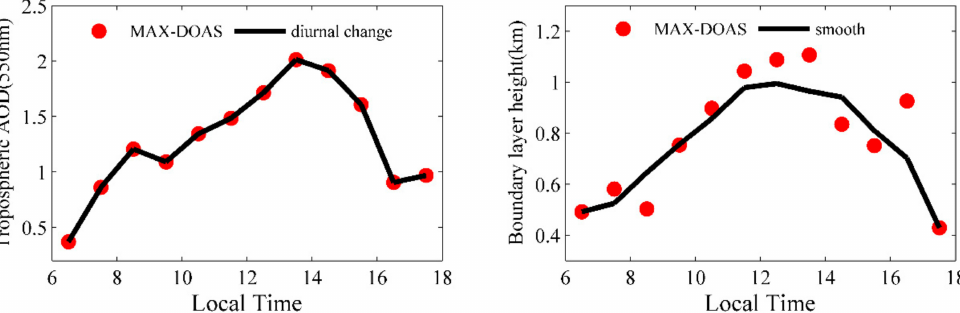
Figure 8. Diurnal variation of AOD and boundary layer height in Shanghai from 28 July to 5 August 2015 (6:00~18:00 LT). The red dots indicate the tropospheric AOD, and boundary layer height retrieved by MAX-DOAS through the lookup table